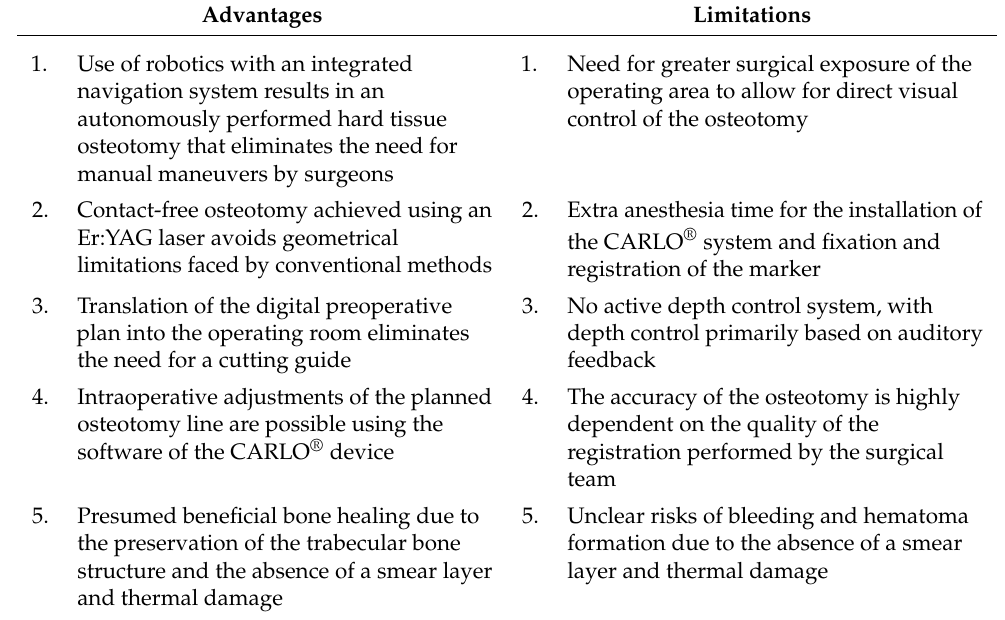
Table 1. Advantages and limitations of the current CARLO ®